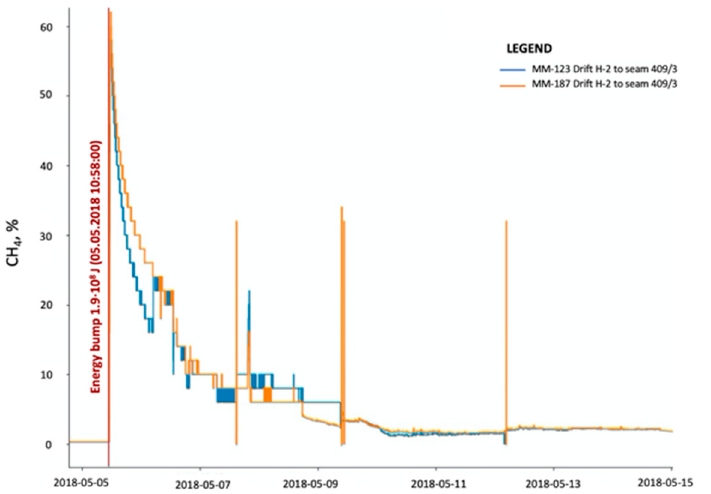
Figure 8. The values of CH 4 concentration recorded by sensors MM-123 and MM-187 (5–15 May 2018)—both sensors marked with rectangles in Figure 3.